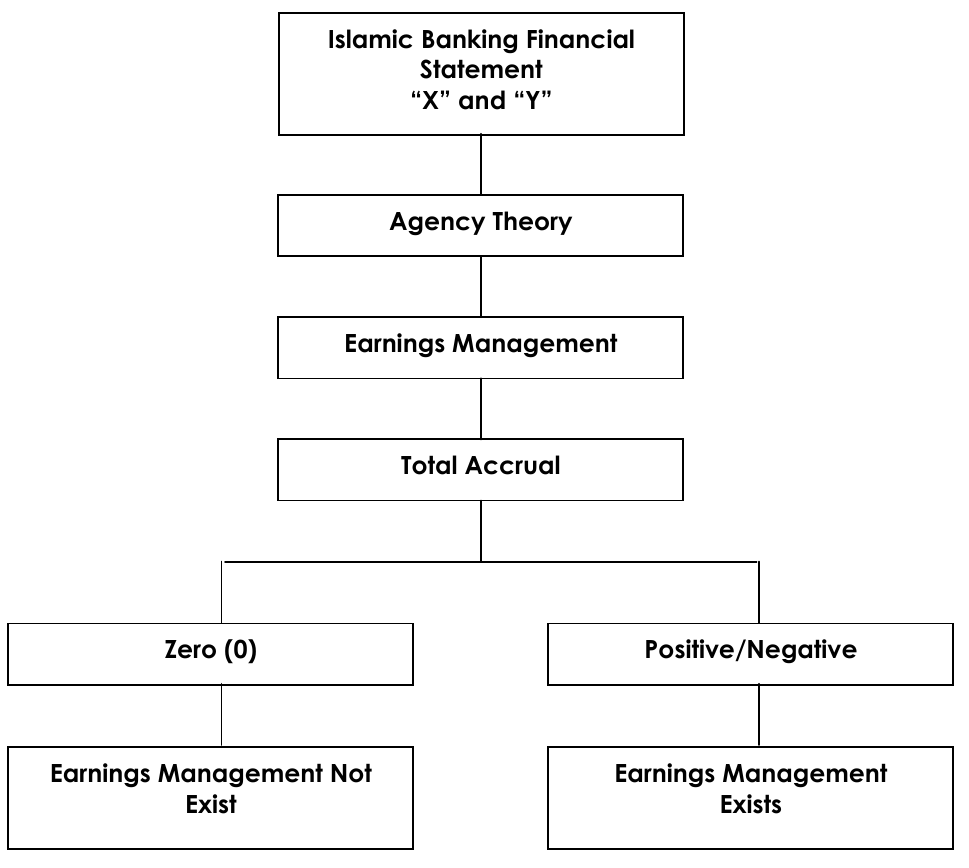
Figure 1. Research Theoretical